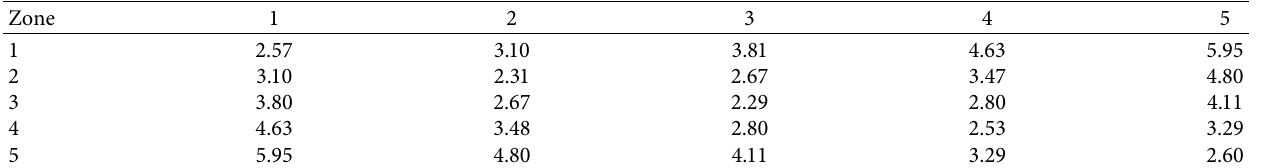
Table 2: Evaluation of the optimal zone fare system scheme.